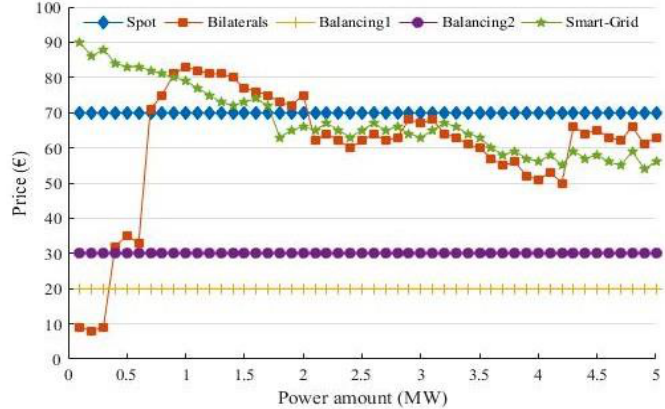
Figure 3. Expected price variation in the different markets, according to the negotiation amount.